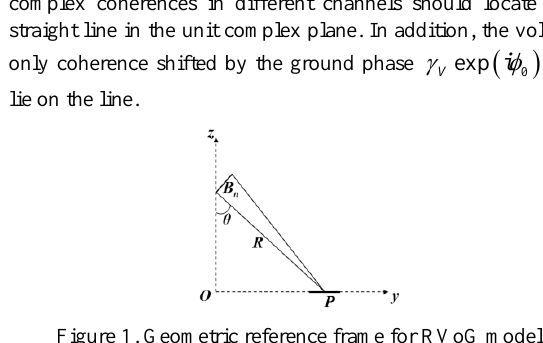
Figure 1. Geometric reference frame for RVoG model